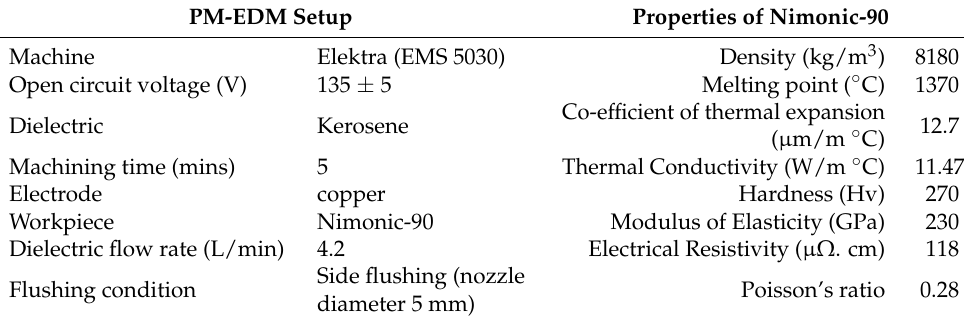
Table 1. Specification of PM-EDM Setup and properties of Nimonic-90.